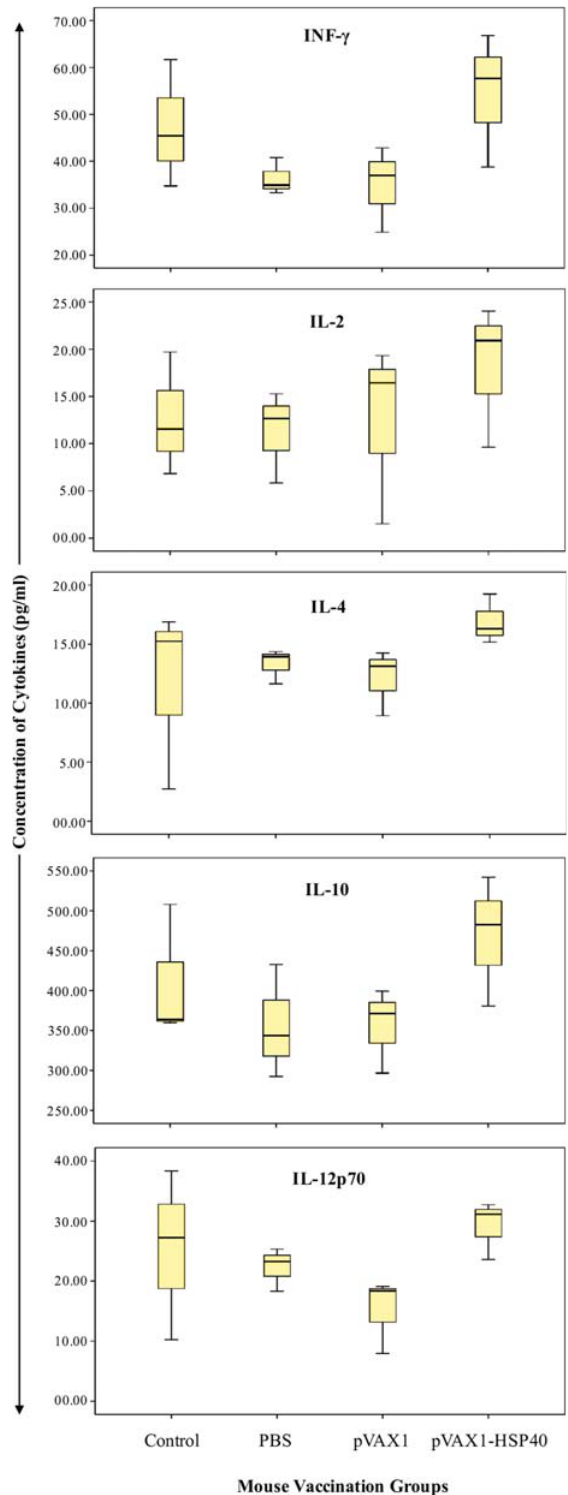
Figure 8. Levels of cytokines in splenocyte culture. Splenocytes were obtained from immunized and control mice prior to the challenge and cultivated in 96-well plates. The levels of IFN- c , IL-2, IL-4, IL-10, and IL-12p70 cytokines in splenic culture supernatants were determined using ELISA. No significant differ- ence was detected between pVAX1-HSP40-immunized mice and control mouse groups ( p > 0.05).